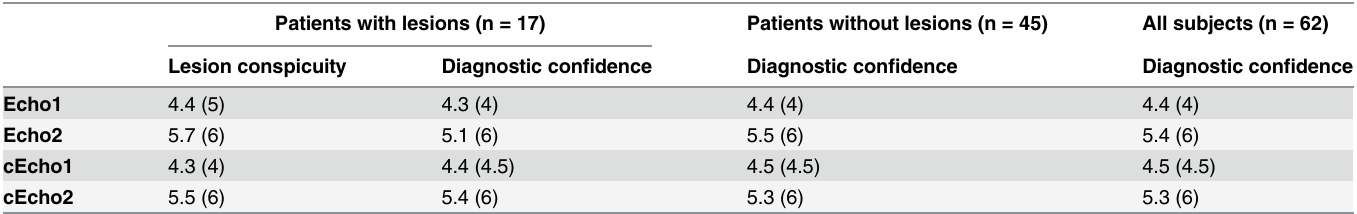
Table 2. Mean and median (in brackets) ratings for reader assessment for Echoes 1 and 2, and their corrected variants.